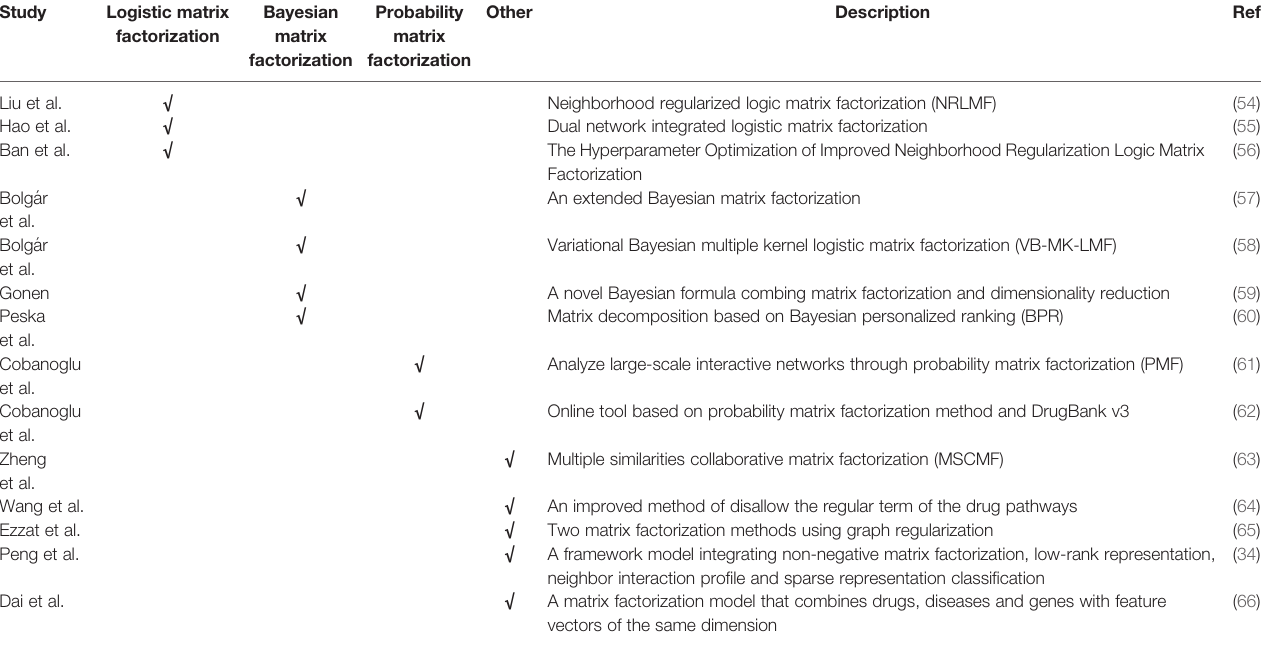
TABLE 2 | Matrix decomposition-based